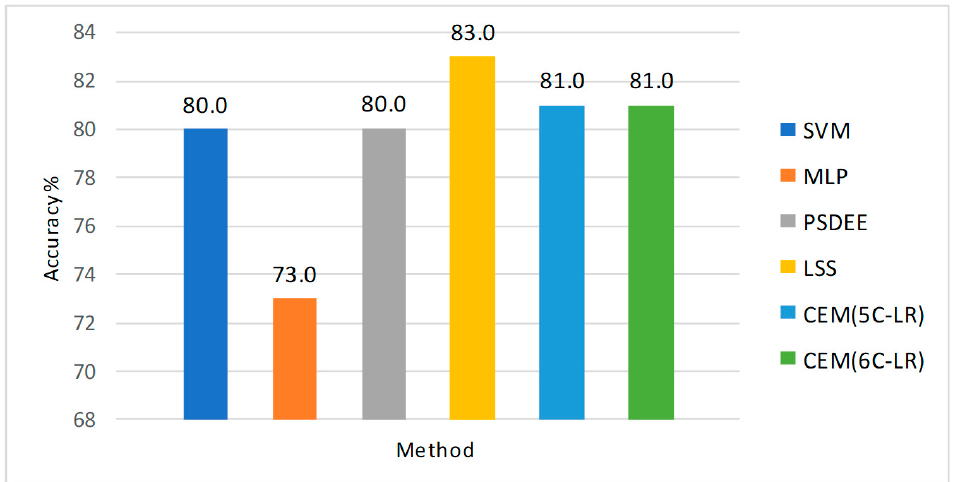
Figure 9. Results experimented on corpus Books.